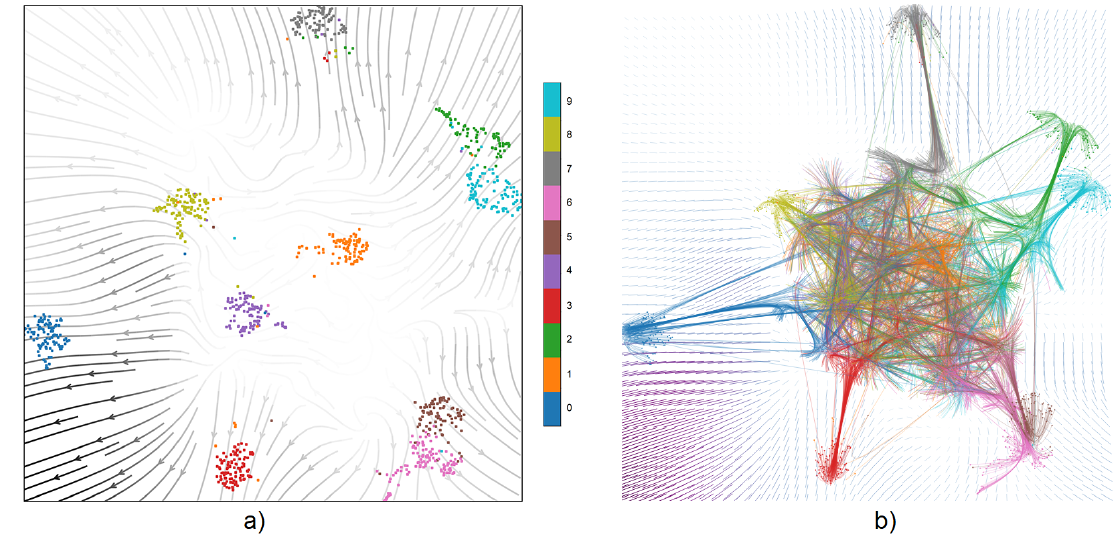
Figure 9. ( a ) projection from the last hidden layer of MobileNetV2 (global average pooling layer) over streamlines from movement trajectories of previous layers. It is possible to see paths that led from a central position to the positions occupied at the current projection, for all points; ( b ) trajectories of points over six layer outputs in the same network model. There is a high amount of clutter in the central section due to the resulting projections of the first layers, but certain movement patterns can be identified. Projected data are obtained using 1000 ImageNet data